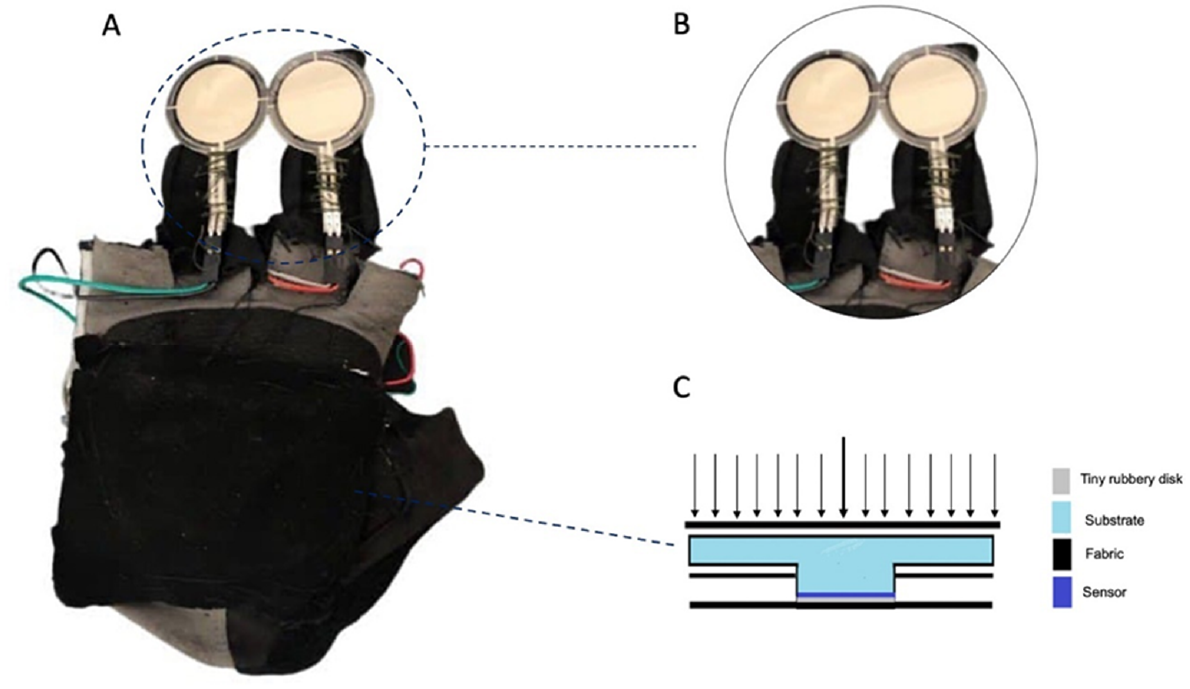
Figure 4. ( A ) Glove prototype, ( B ) Flexiforce force sensors, ( C ) Layers of prototype in the glove (shown with gray as tiny rubbery disk, light blue as substrate, black as fabric, and dark blue as sensor).